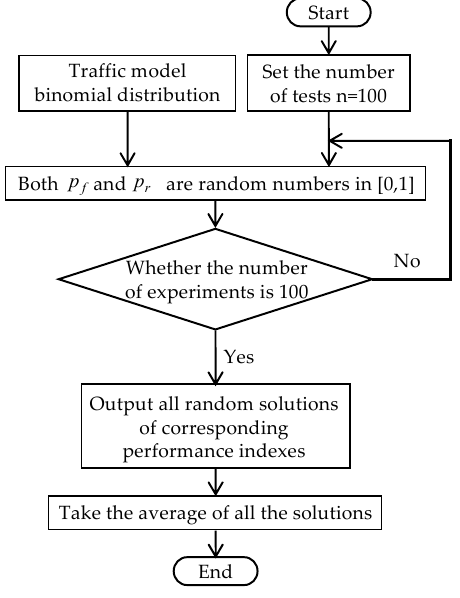
Figure 7. Flow chart of the Monte ‐ Carlo simulation.